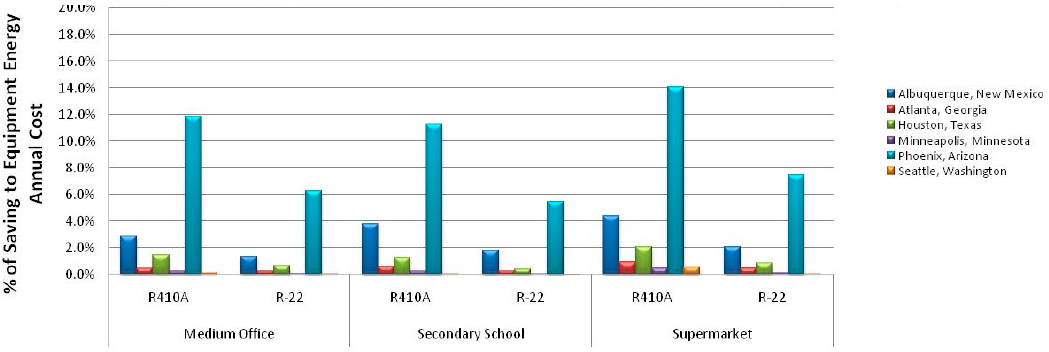
Figure 10. Percentage of energy savings due to pre-cooling relative to no pre-cooling when water is sprayed after ambient temperature equals or exceeds 90 °F/32.2 °C. Wet bulb efficiency = 0.7, COP = 3.